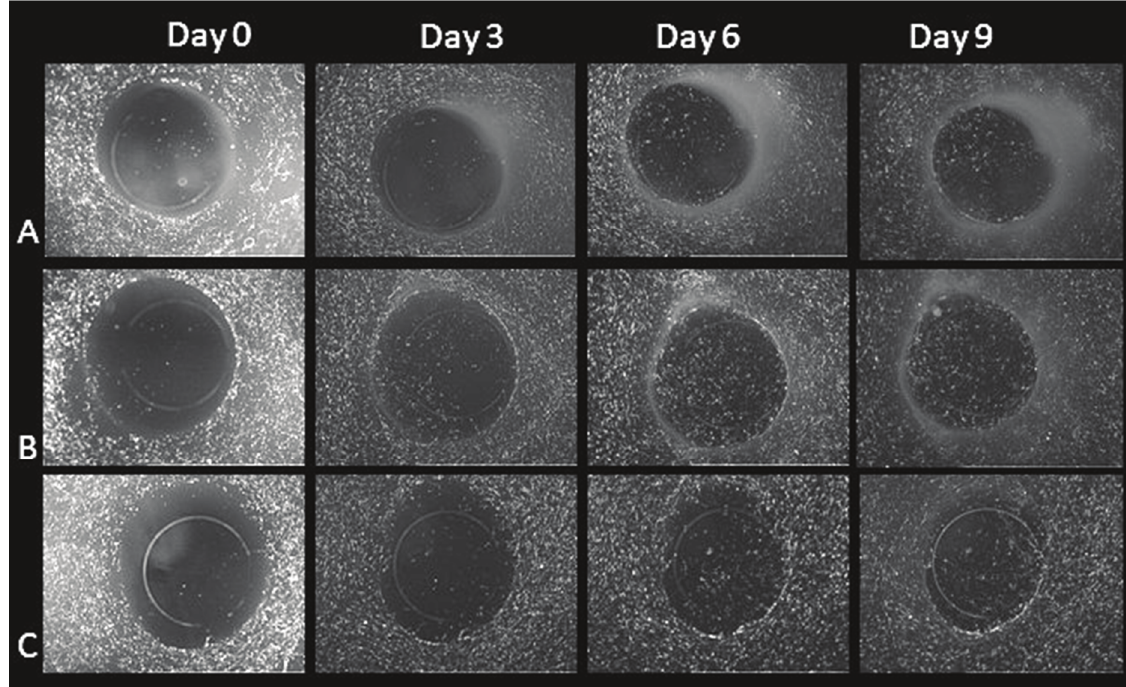
Figure 6. Three-dimensional wound migration assay. Fibroblast migration from collagen to a fibrin defect with ( A ) control medium, ( B ) conditioned medium from a scratched 2D layer of HFFs, or ( C ) conditioned medium from a non-scratch confluent 2D layer of HFFs. Migration measured using ImageJ as distance from wound edge to edge of migrated cells. Cells began to infiltrate the wound area by day 3 and cover the wound by day 6 for defects that had a similar size, shown here. For larger defect areas, cells completely covered the wound by day 9 in the majority of cases. Images taken at 2.5 ×